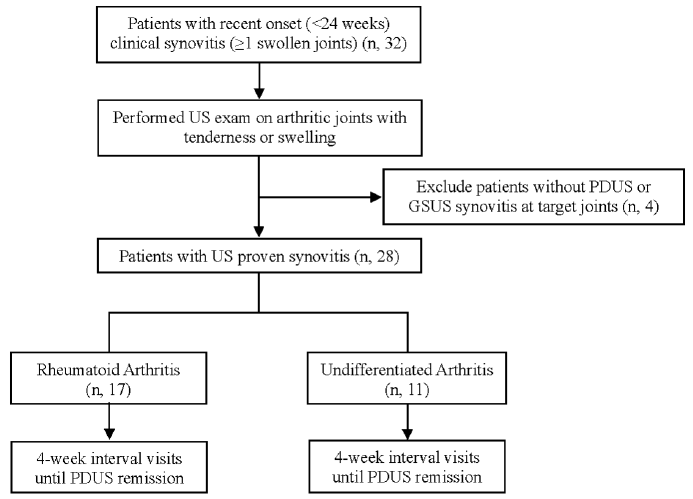
Figure 1. Patient selection flow. US, Ultrasonography; PDUS, Power doppler ultrasonography; GSUS, Grey scale ultrasonography. Table 1. Demographic and clinical